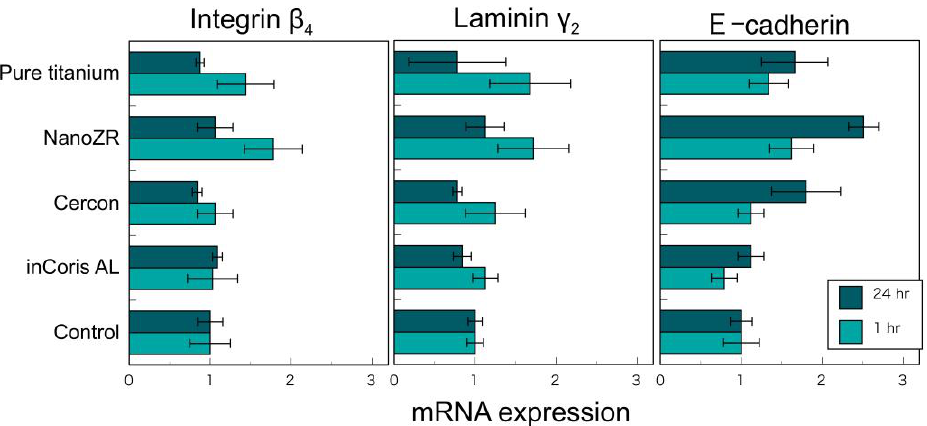
Figure 22. m-RNA expressions of integrin β 4 , laminin γ 2 , and E-cadherin in Ca9-22 cells on pure titanium, NanoZR, Cercon ® (3Y-HA zirconia), inCoris AL ® (alumina), and control polystyrene at 1 and 24 h. Adopted from Ref. [69].